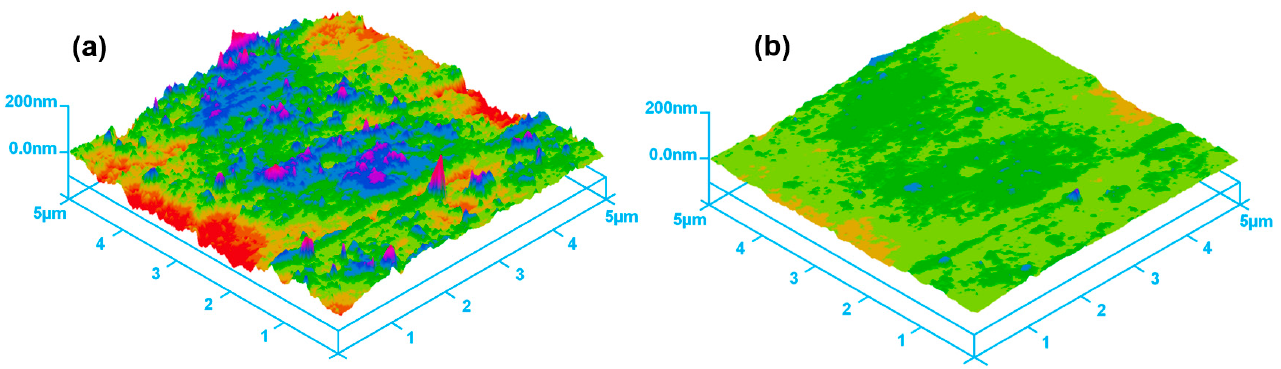
Figure 4. AFM surface topography images of ZrO 2 ceramic: ( a ) before processing ( Ra : 0.18 μ m), and ( b ) after processing ( Ra : 0.02 μ m), reused with permission from Elsevier [16].